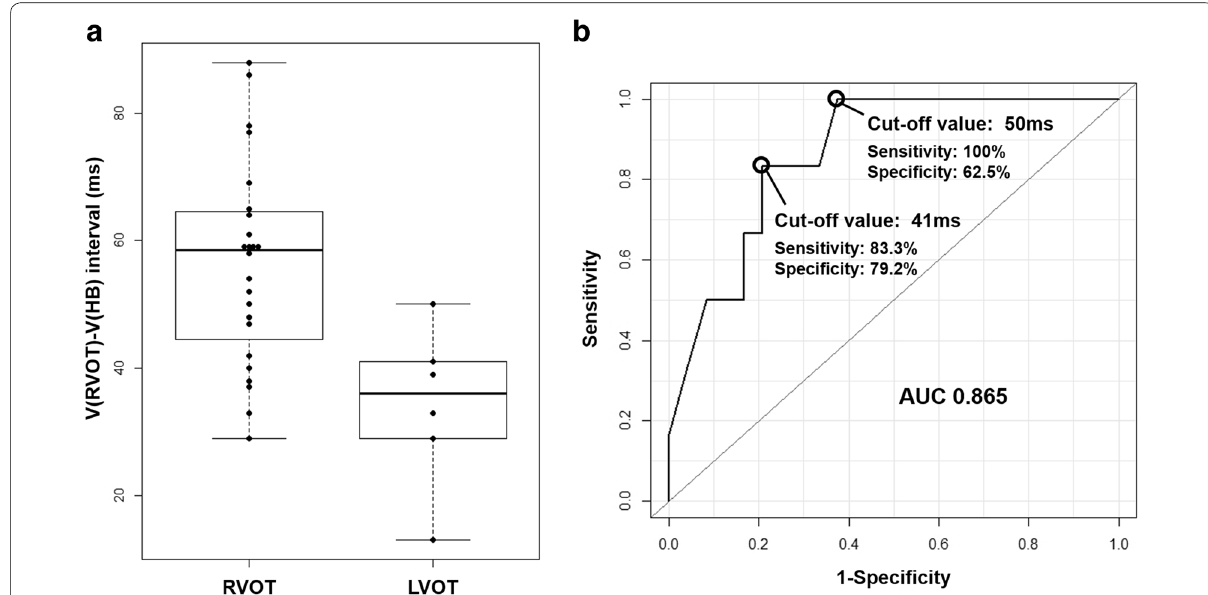
Fig. 3 a Boxplots of the V(RVOT)‑V(HB) intervals (interval from the RVOT electrogram to V signal in the His bundle electrogram) for idiopathic ventricular arrhythmia originating from the RVOT and LVOT. b ROC curve of the V(RVOT)‑V(HB) interval. A V(RVOT)‑V(HB) interval cutoff of predicted an origin from the LVOT with 100% sensitivity and 62.5%